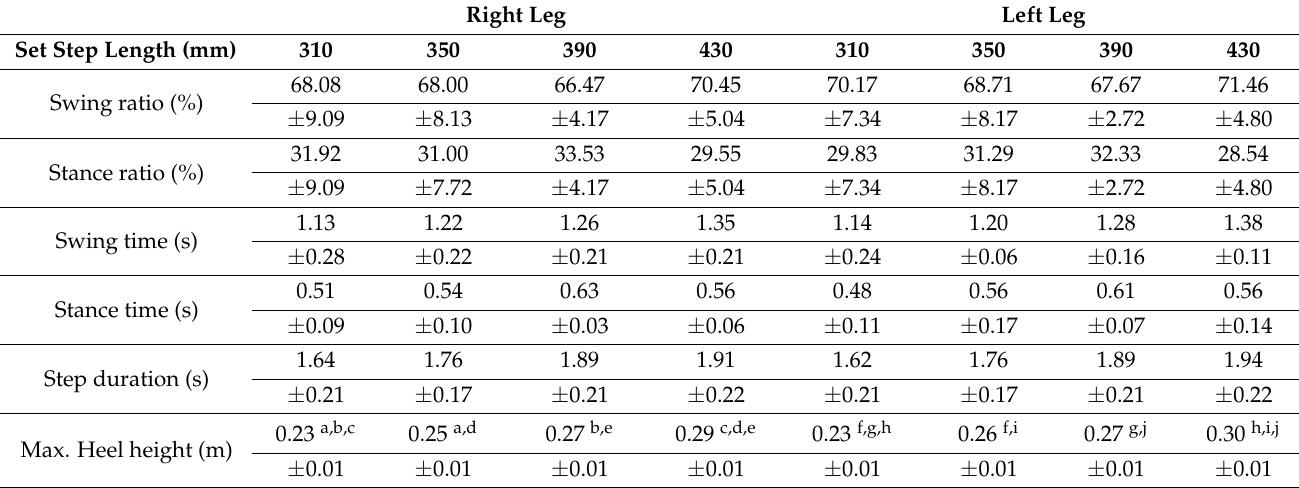
Table 2. Results of the gait event parameter by step